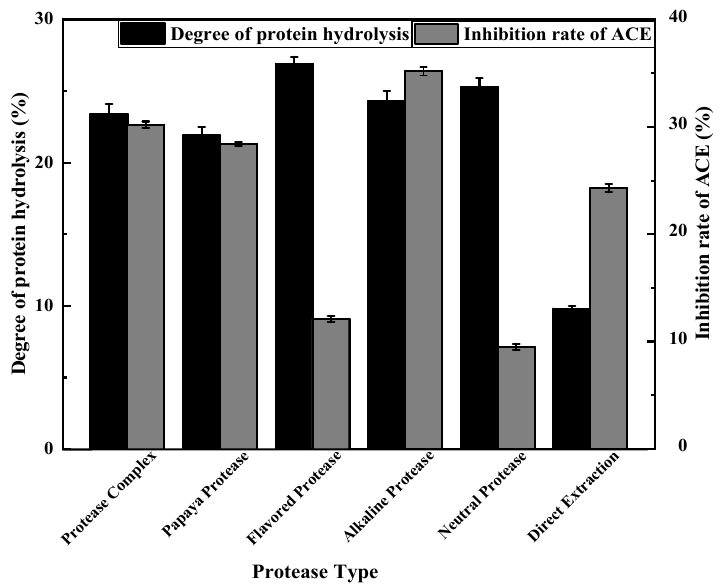
Figure 2. The effect of different proteases on the degree of hydrolysis and the inhibition rate of ACE.